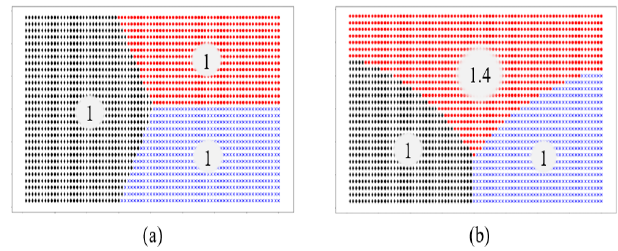
Figure 3. The area partition based on a multiplicatively weighted (MW) Voronoi diagram in three robot cases: ( a ) the area divided into three sub-areas by the same weights and ( b ) the area divided into three sub-areas by the weight of 1.4 for one sub-area.